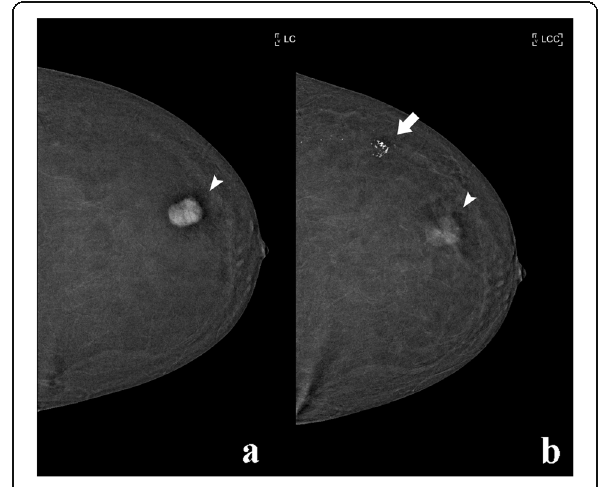
Fig. 5 Contrast splatter. CEDM was performed in a 55-year-old woman for preoperative staging. a The recombined image shows an avidly enhancing lesion in the outer quadrant (arrowhead). b A delayed acquisition was performed where contrast contamination of the skin is visible (arrow). Contrast washout is also demonstrated within the lesion (arrowhead)